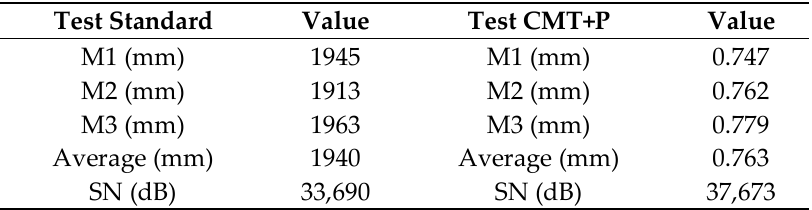
Table 3. Penetration values obtained in the confirmation experimental tests.